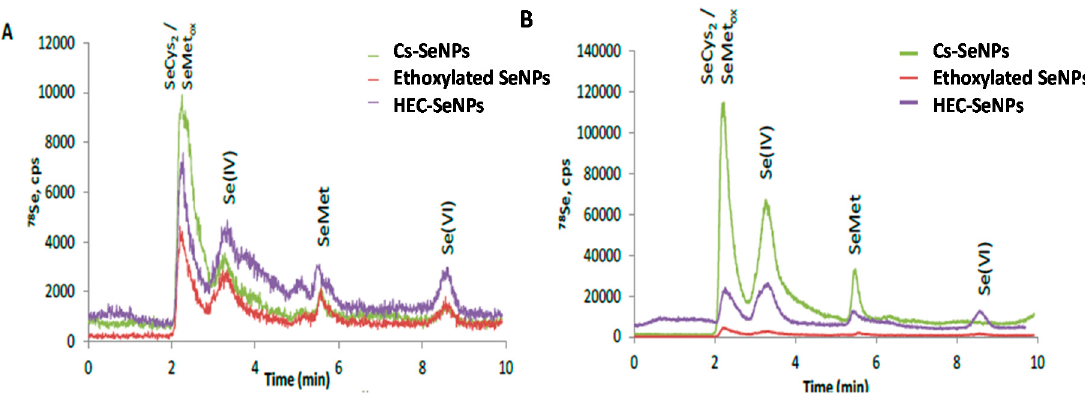
Figure 5. Transformation of SeNPs by L. d. bulgaricus LB-12. Anion-exchange high performance liquid chromatography on line coupled to inductively coupled plasma mass spectrometry (HPLC-ICP-MS) chromatogram of hydrolyzed extracts of bacterial cell pellet after exposure to ( A ) 1 µ g Se mL − 1 and ( B ) 10 µ g Se mL − 1 over 24 h. SeMet: Selenomethionine, SeMetox: Selenonmethionine-Se-oxide and Se(IV) selenite.